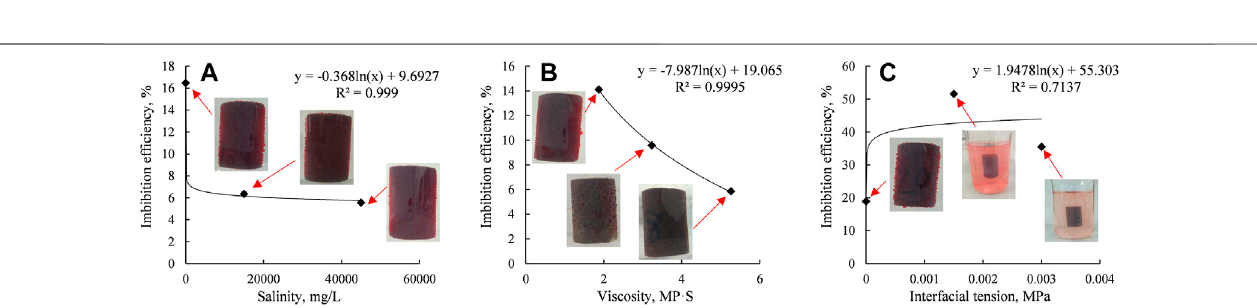
FIGURE 3 | Final spontaneous imbibition ef fi ciency evolution with different (A) brine salinity, (B) oil viscosity, and (C) interfacial tension.